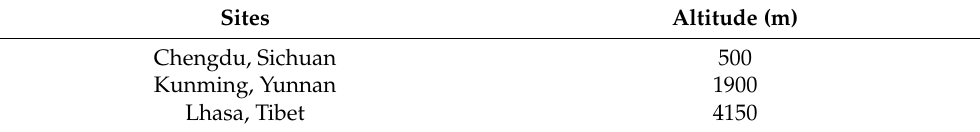
Table 1. Experimental